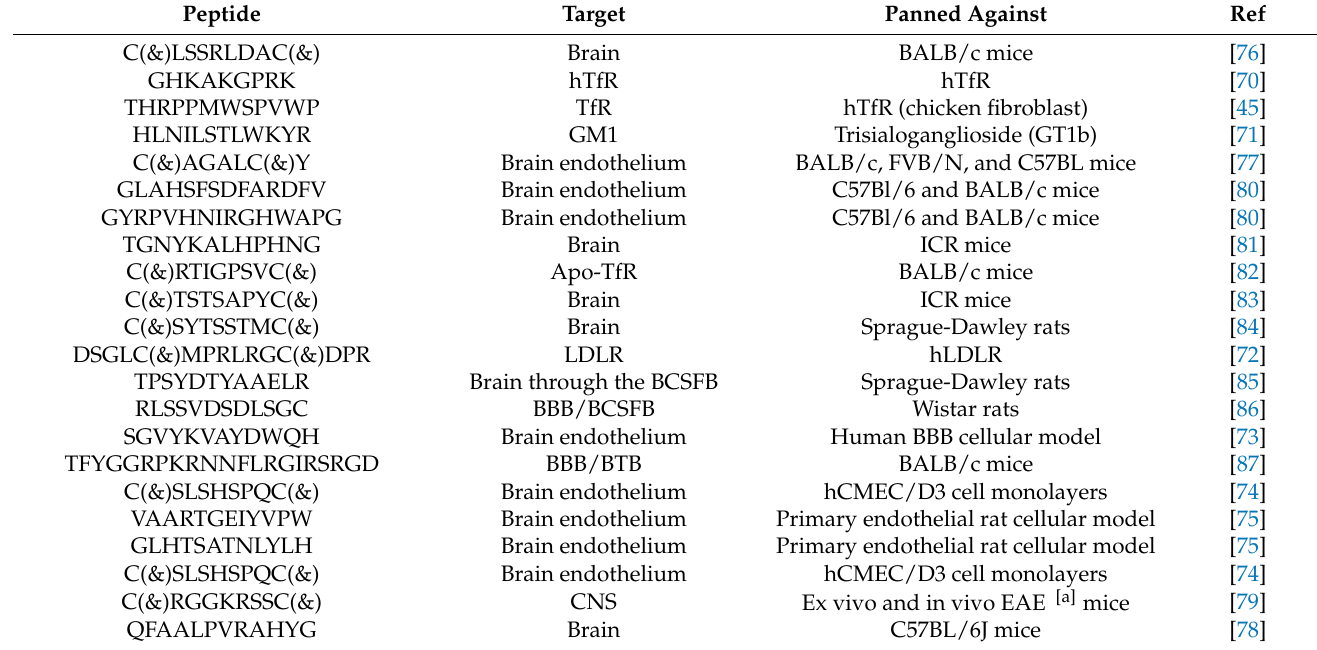
Table 2. Brain -targeting peptides discovered by phage